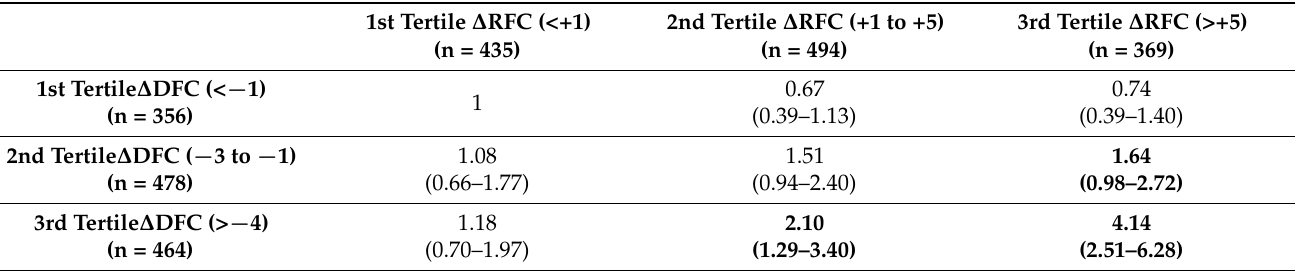
Table 4. Adjusted ORs* (95% CI) of ∆ body weight (reduction above the median value) according to the tertiles of ∆ RFC and ∆ DFC after 1 year of dietary